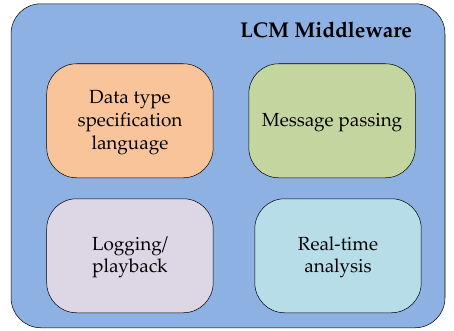
Figure 15. LCM middleware, as described in [58].